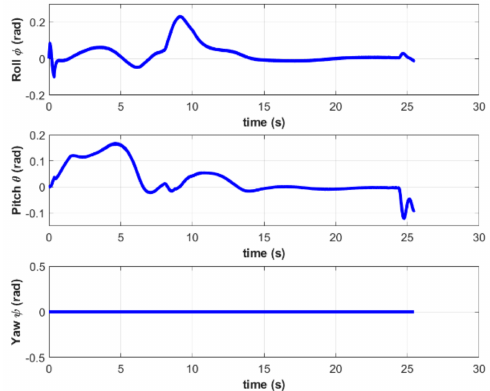
Figure 8. Attitude of the quadrotor in simulation A.